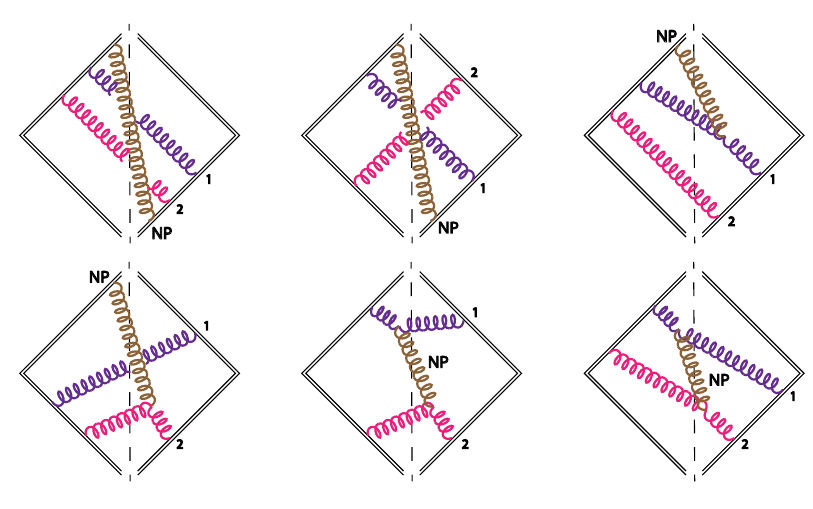
Figure 26 . Examples of diagrams with one perturbative soft drop failing or unresolved gluon (purple, labeled 1), one perturbative soft drop passing gluon (magenta, labeled 2), and a nonper- turbative gluon (brown, labeled NP). Dashed line represents measurement of the plus momentum of the passing gluon along with the soft drop operator. Eikonal emissions of perturbative gluons are considered. Diagrams with virtual perturbative gluons are not shown. Graphs with a virtual NP gluon are not